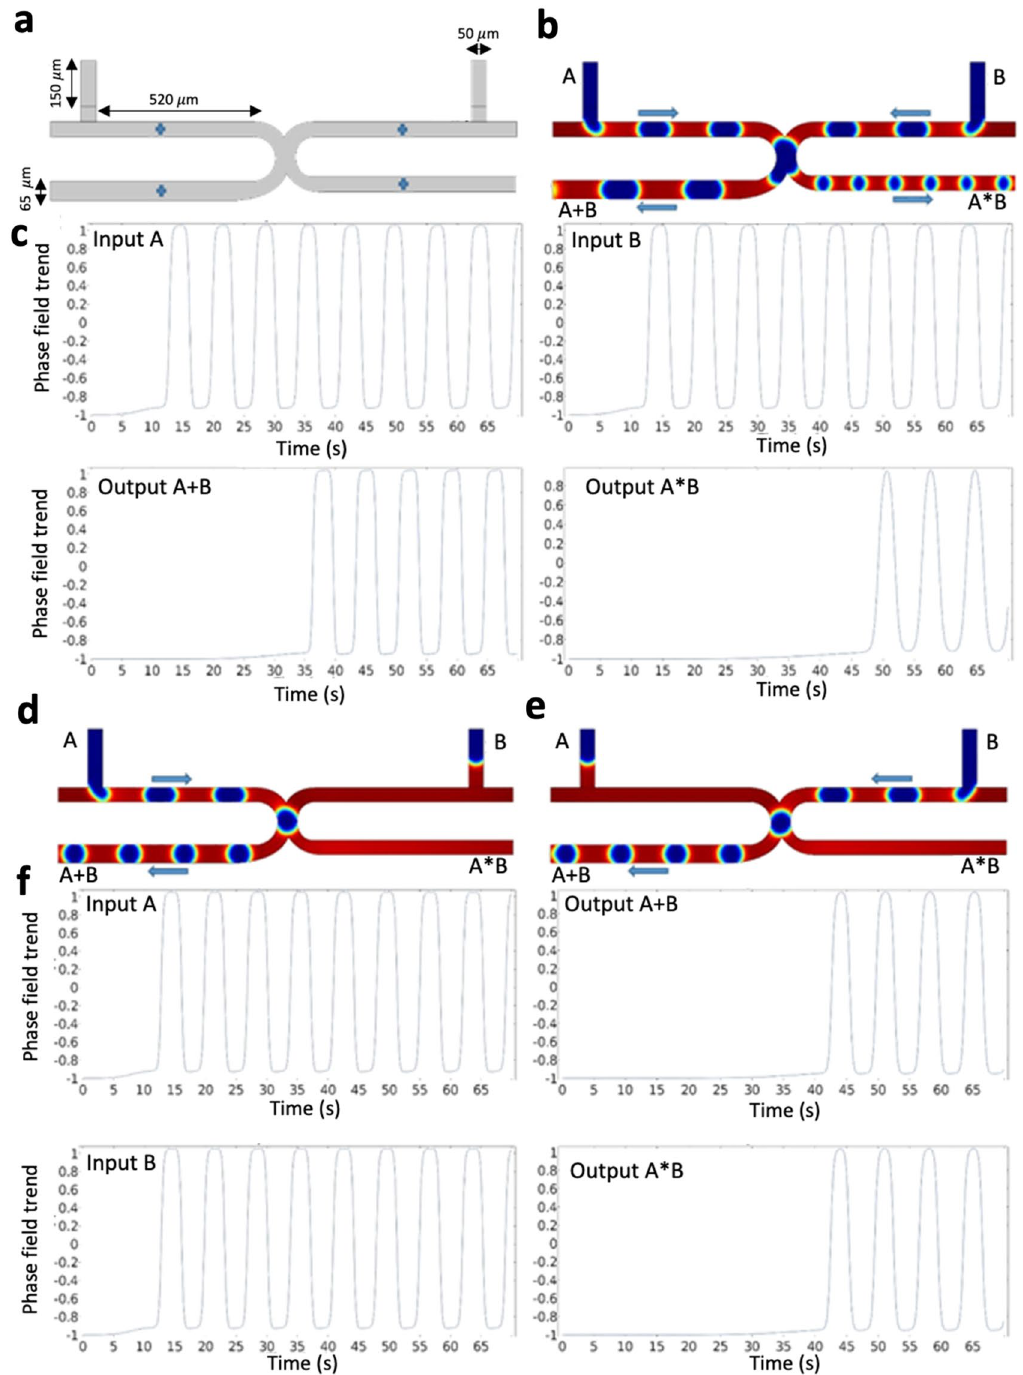
Figure 2. The microfluidic AND/OR type 1 gate. ( a ) The design and geometry of the microchannels. Probe points (blue points) are used to quantify the phase-field value. ( b ) A snapshot in the case (1–1) and an indication of the bubble direction. ( c ) Phase-field trends of both the inputs (having the same trend), and phase field trends of the outputs ( A + B ) and ( A ∗ B ). The difference between the phase-field trend of ( A + B ) and ( A ∗ B ) shows that the bubbles in the OR gate reach the output sooner than the AND gate. ( d ) A snapshot in the case (1–0), and ( e ) a snapshot in the case (0–1). ( f ) The phase-field trends of the input A and the output ( A + B ), and the phase-field trend of the input B and the output ( A ∗ B